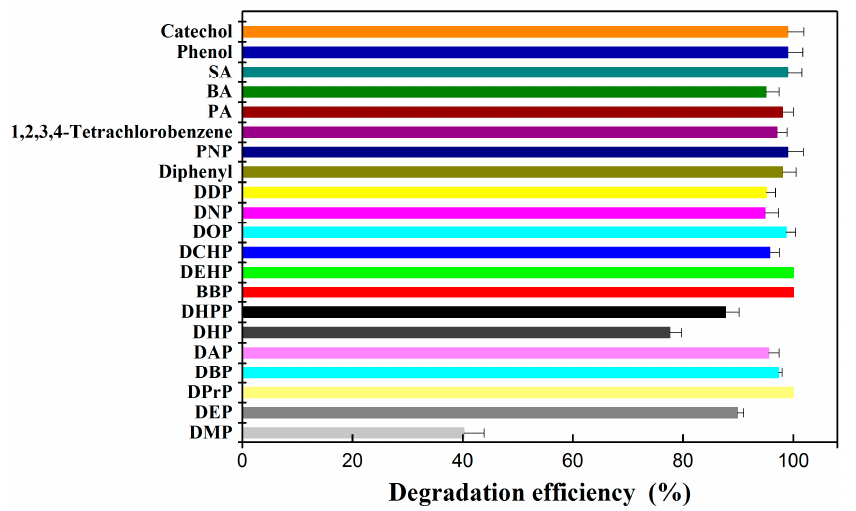
Figure 6. The degradation efficiency of individual phthalic acid esters (PAEs), including DEHP, dimethyl phthalate (DMP), diethyl phthalate (DEP), di- n -butyl phthalate (DBP), benzyl butyl phthalate (BBP), di-cyclohexyl phthalate (DCHP), di-propyl phthalate (DPrP), dipentyl phthalate (DAP), dihexyl phthalate (DHP), di- n -heptyl phthalate (DHPP), dioctyl phthalate (DOP), di-nonyl phthalate (DNP), and di-decyl phthalate (DDP); and some kinds of aromatic compound, including diphenyl, p-nitrophenol (PNP), 1,2,3,4-tetrachlorobenzene, phthalic acid (PA), salicylic acid (SA), benzoic acid (BA), phenol, and catechol. The structures of the target substrates are presented in Supplementary Figure S1. Error bars indicate standard deviations of the means.